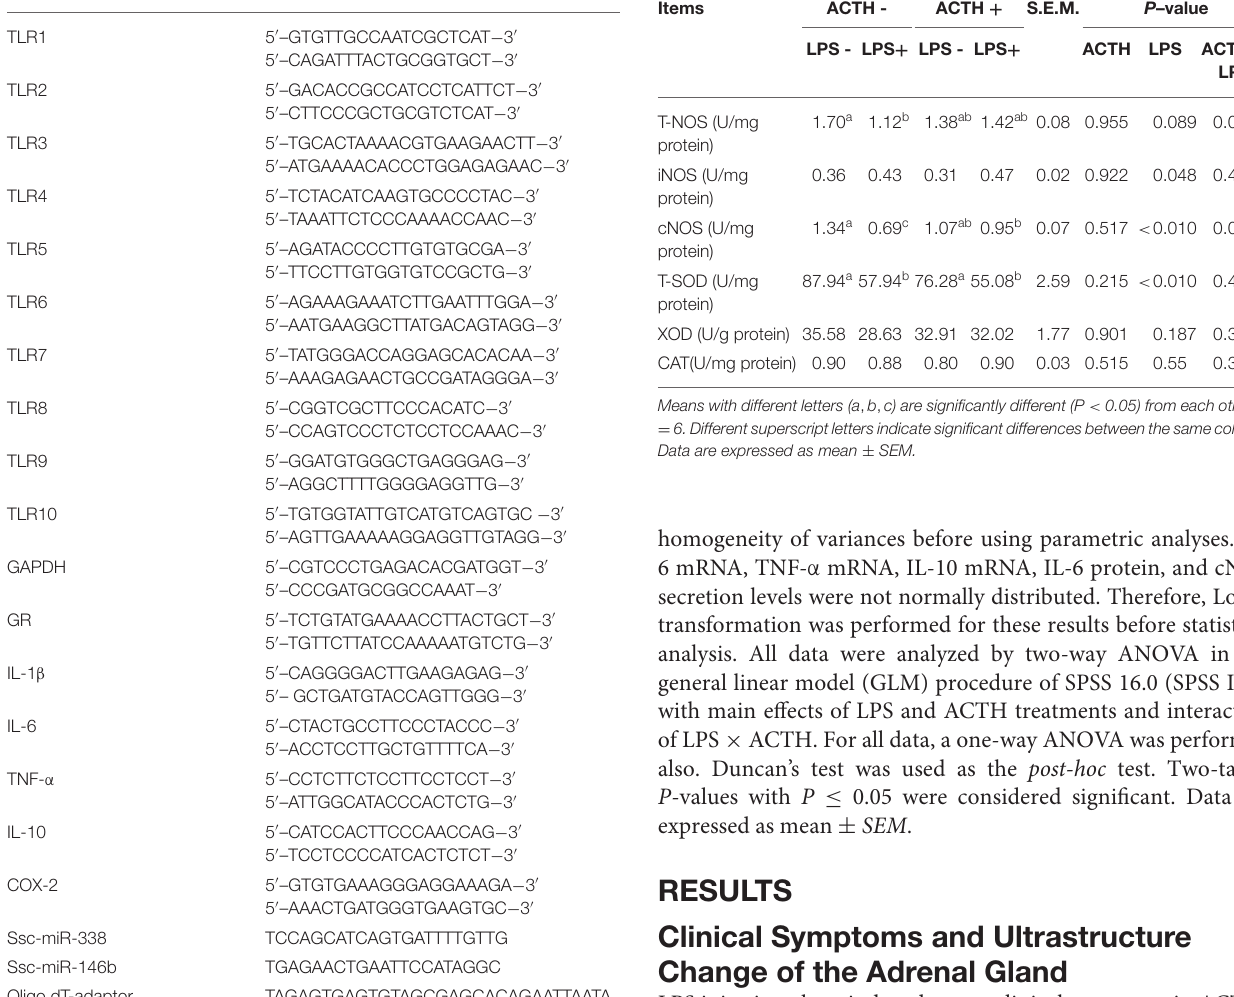
TABLE 2 | Effects of LPS/ACTH on oxidative stress response in local porcine adrenal tissue. Items ACTH - ACTH +